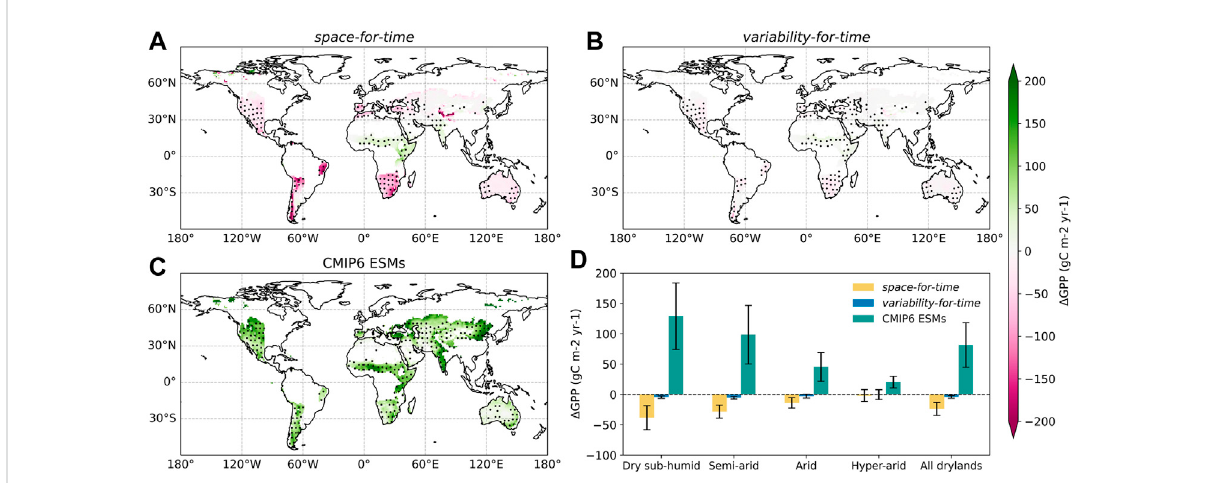
FIGURE 2 The spatial distributionof futureGPP changes basedon thespace-for-time approach,thevariability-for-time approach, andactualprojections from CMIP6 ESMs. The GPP changes are calculated by subtracting the historical GPP during 1958 – 2014 from the projected GPP over the last 2 decades of the 21st Century. (A) GPP changes predicted by the space-for-time approach. (B) GPP changes predicted by the variability-for-time approach. (C) GPPchangespredictedbytheoriginalCMIP6ESMs.Insubplots (A – C) ,thecolorbarrepresentstheensembleaverageofestimates by 18 CMIP6 ESMs, and theblack dots denote regions where more than 80% ESMs show the same sign as the multi-model ensemble mean. (D) GPP